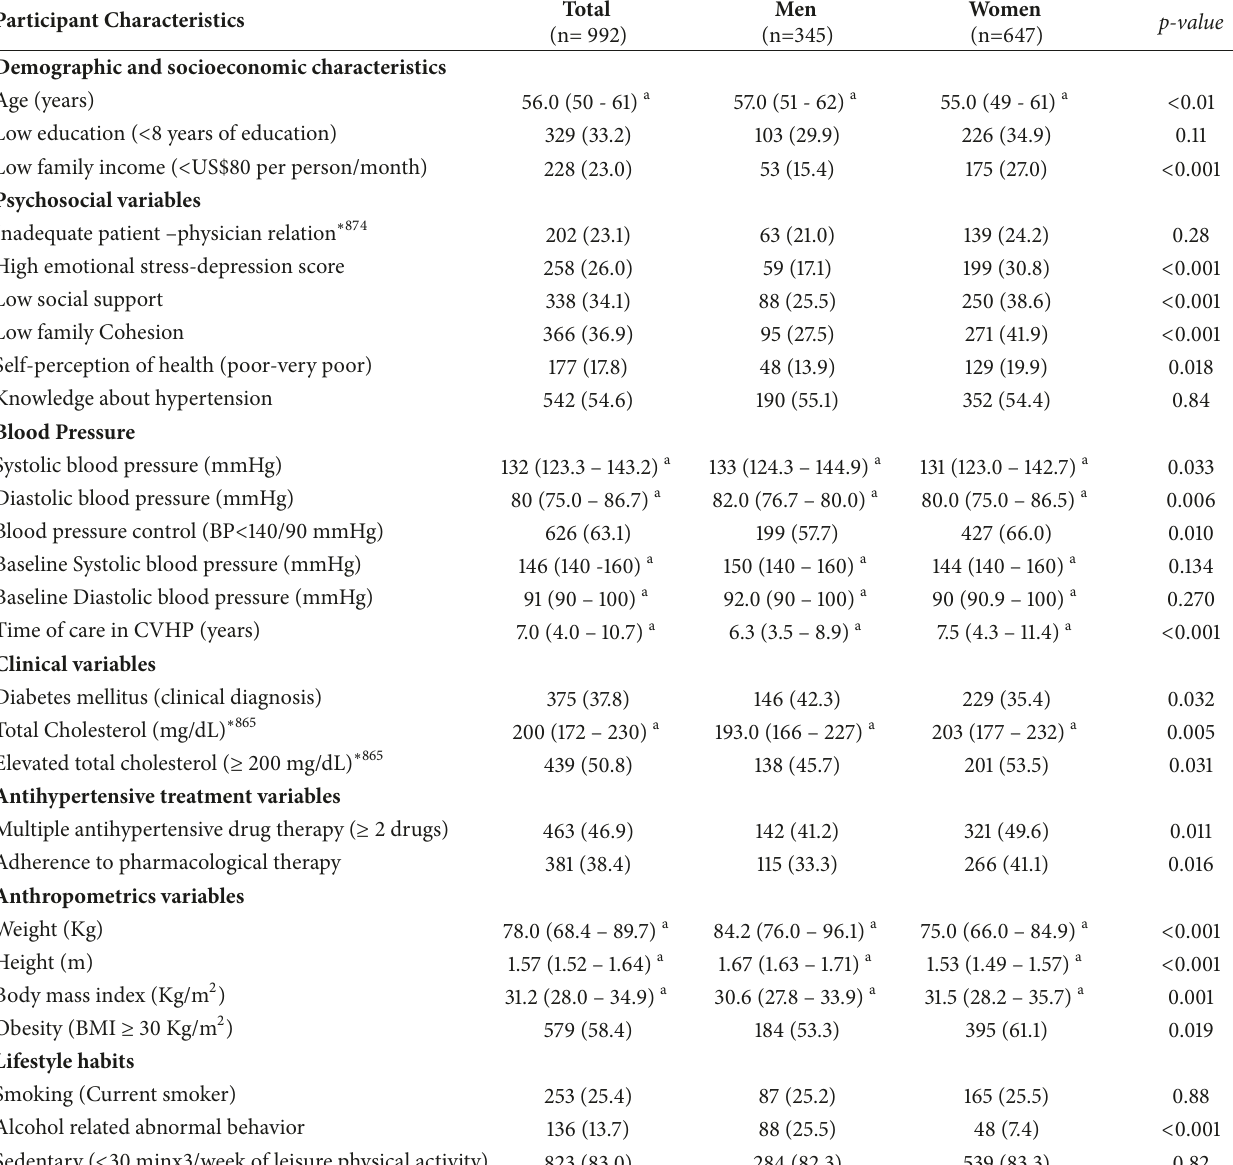
Table 1: Demographic, socioeconomic, clinical, and antihypertensive therapy and anthropometric characteristics